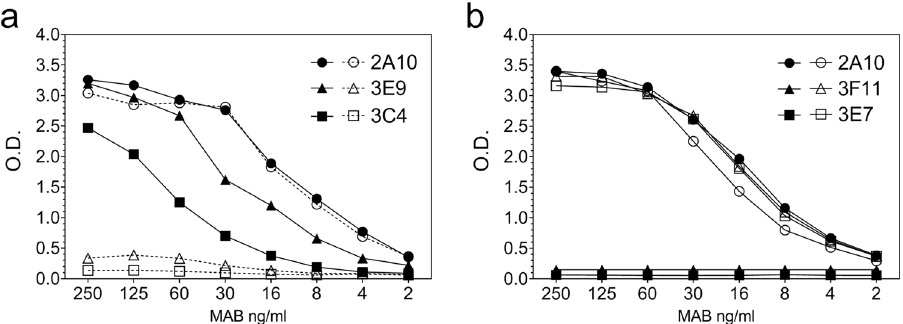
Fig. 5 Fine speci fi city of MAB derived from mice immunized with linear minor or major repeat peptides. a MABs 3E9 and 3C4 derived from mice immunized with (T1T*) minor repeat peptide, or b MABs 3F11 and 3E7 derived from mice immunized with the (BT*) major repeat peptide, were tested by ELISA against wells coated with minor repeat peptide (closed symbols) or major repeat peptide (open